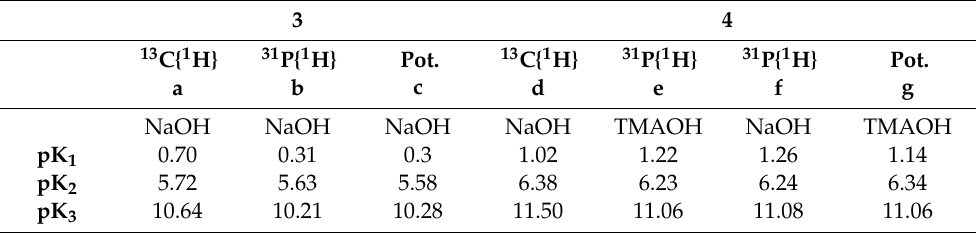
Table 6. Macroscopic dissociation constants pK i of compounds α -Ala-P 3 and β -Ala-P 4 obtained by 13 C{ 1 H}- and 31 P{ 1 H}-NMR-controlled titrations and by potentiometric titrations [4a]. Note: pK pK 2 > 3 and pK 2 − pK 1 > 3 for compounds 3 and 4 . Exp.: 3: C Titrand : a) 0.0867 mol / L 3 + 0.0834 mol / L HNO 3 . b) and c) 0.005 mol / L 3 + 0.00476 HNO 3 + 0.0917 mol / L NaNO 3 . C Titrator : a) 3.98 mol / L NaOH. b) and c): 0.100 mol / L NaOH. 4 : C Titrand : d) 0.139 mol / L 4 + 0.139 mol / L HNO 3 . e) 0.010 mol / L 4 +